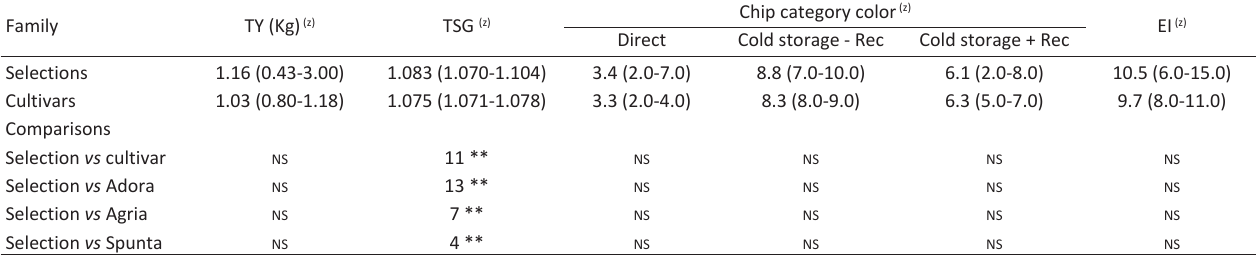
(z) number of clones with a significantly better score compared to the control. nS , *, ** indicates that means are not different or statistically different at p<0.05 and p<0.01, respectively ( lSD